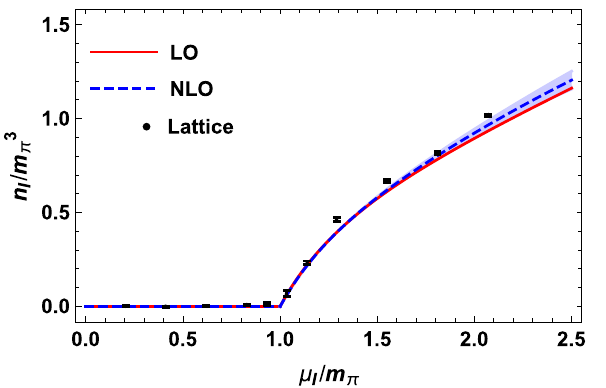
Fig. 4 Normalized isospin density as a function of the normalized isospin chemical potential. The red curve shows the tree-level result and the blue curve shows the one-loop result using the central values m cen and f cen . The band is obtained by varying m and f in their respec- tive ranges. The points are lattice data from Ref. [46]